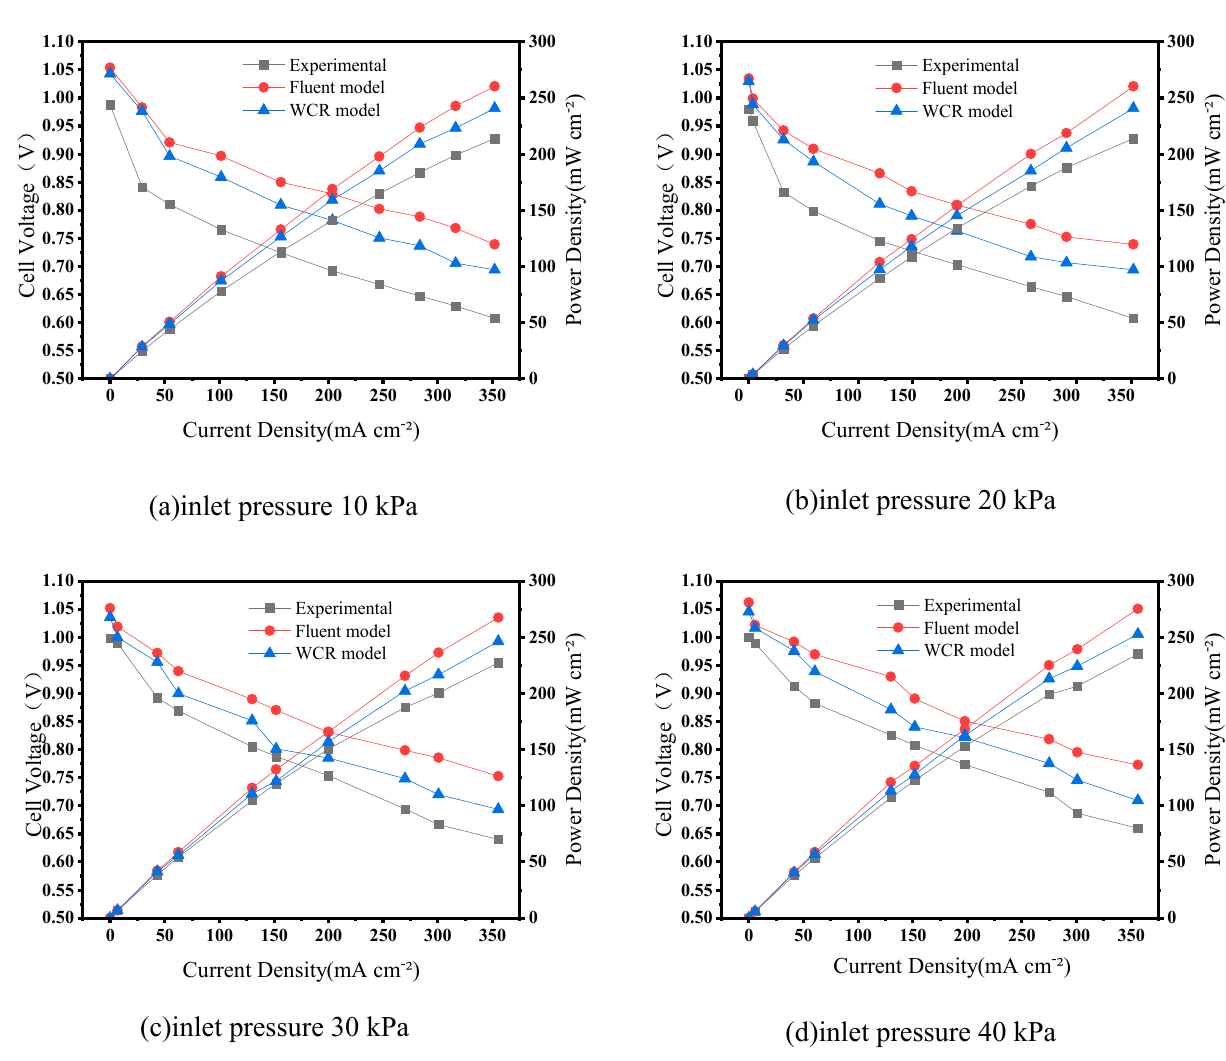
Figure 6. Polarization curves at different inlet pressures: ( a ) 10 kPa, ( b ) 20 kPa, ( c ) 30 kPa, ( d ) 40 kPa. The amount of water generated is meager and the water content inside the fuel cell is insufficient, which causes the membrane to dry out and the ohmic impedance to continue to increase, resulting in a drop in the voltage. Moreover, the amount of water migration is less than the anti-diffusion of water; in other words, the amount of water generated by the electrochemical reaction and humidified by the reaction gas is less than the amount of water discharged by the fuel cell, which will lead to the dehydration of the proton exchange membrane and damage to the fuel cell life and performance. When the current density increases from 50 mA · cm − 2 to 280 mA · cm − 2 , the voltage linearly decreases with the increasing current. The voltage of the WCR model decreases from 0.90 V to 0.76 V, the voltage of the Fluent model decreases from 0.93 V to 0.79 V, and experimental voltage decreases from 0.81 V to 0.65 V, with average declines of 6.08 × 10 − 4 V (mA · cm − 2 ) − 1 , 6.08 × 10 − 4 V (mA · cm − 2 ) − 1 and 6.95 × 10 − 4 V (mA · cm − 2 ) − 1 , respectively. The accuracy of the WCR model is 21% higher than that of the Fluent model. At this point, the water generated by the humidification reaction gas and the electrochemical reaction means that the membrane is completely hydrated. In addition, the gradual increase in the condensation rate contributes to the increase in the liquid water content, and some water remains in the CL, which is conducive to enhancing the overall conductivity of the polymer and making the voltage drop slowly. When the current density is larger than 280 mA · cm − 2 ,